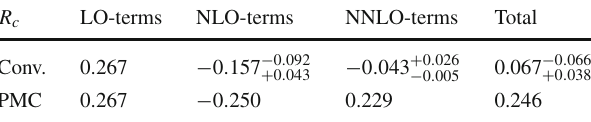
Table 1 Contributions from each loop terms for R c up to NNLO level under conventional (Conv.) and PMC scale-setting approaches, respec- tively. The PMC predictions are scale invariant, and the Conv. predic- tions are highly scale dependent, whose central values are for μ r = m c and the errors are for μ r ∈ [ 1 GeV , 2 m c ] . μ (cid:12) = 1 GeV R